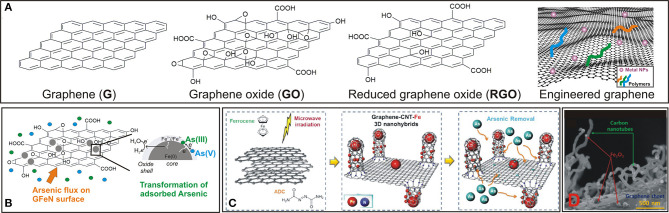
(A) Graphene-based materials (graphene, graphene oxide, reduced graphene oxide and engineered graphene). (B) Schematic representation of GO-iron nanohybrid (GFeN) and the proposed mechanism involved for arsenic removal. (C) Representative example of hierarchically porus 3D assembly (G-CNT-Fe 3D) and the related SEM image (D) “Reproduced with permission of (Vadahanambi et al., 2013), (Copyright 2020), American Chemical Society”.